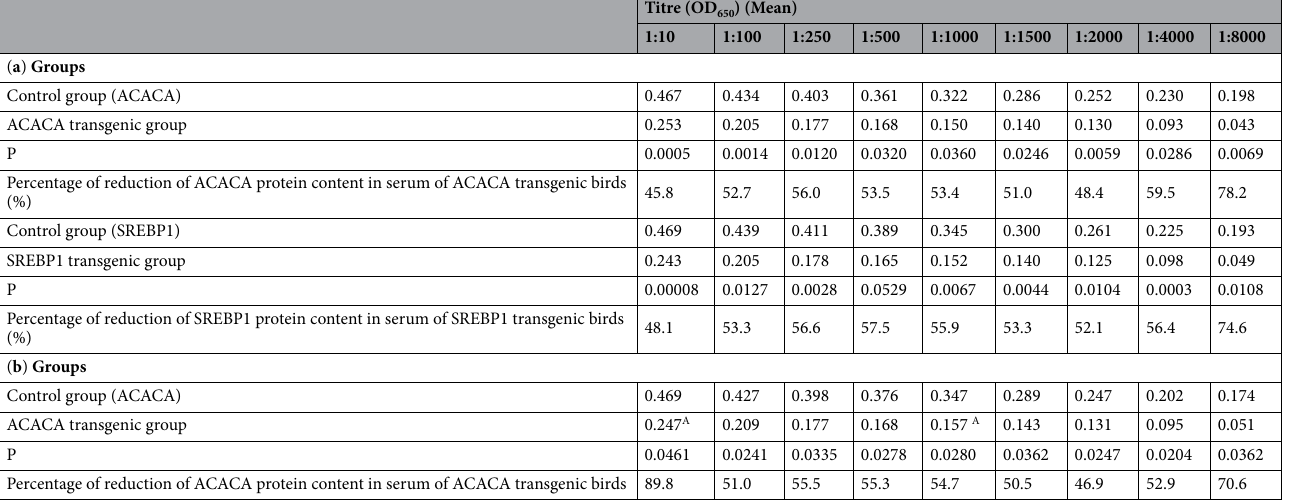
Table 2. Detection of ACACA and SREBP1 proteins (OD 650 values) in the serum of transgenic and control birds at the age of 6 weeks by sandwich ELISA. a Birds of 1st generation. b Birds of 2nd generation. Controls (ACACA) in both (a) and (b) indicate quantification of ACACA protein in serum of the control birds. Control (SREBP1) indicates quantification of SREBP1 protein in terms of OD 650 values in serum of control birds during 1st generation (a). Comparisons of quantity of ACACA protein in serum between control (ACACA) and ACACA knockdown birds of 1st (a) and 2nd (b) generations reveal highly significant differences of this protein between two groups in each generation demarcated by different superscripts (a/b) and (A/B), respectively. Comparison of quantity of SREBP1 protein in serum between control (SREBP1) and SREBP1 knockdown birds of 1st generation (a) reveals highly significant differences of this protein between these two groups demarcated by different superscripts (x/y). Both ACACA and SREBP1 proteins in serum of knock down birds of ACACA and SREBP1 groups were lower than those of control birds indicating efficiency of silencing expression of the SCACA and SREBP1 genes in knock down birds.